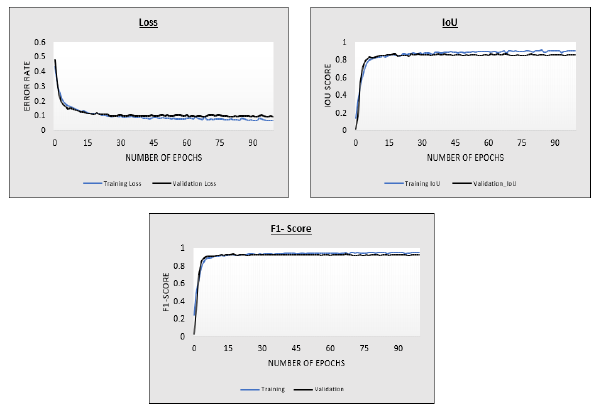
Figure 4: Training and Validation curve for Loss, IOU, and F1-